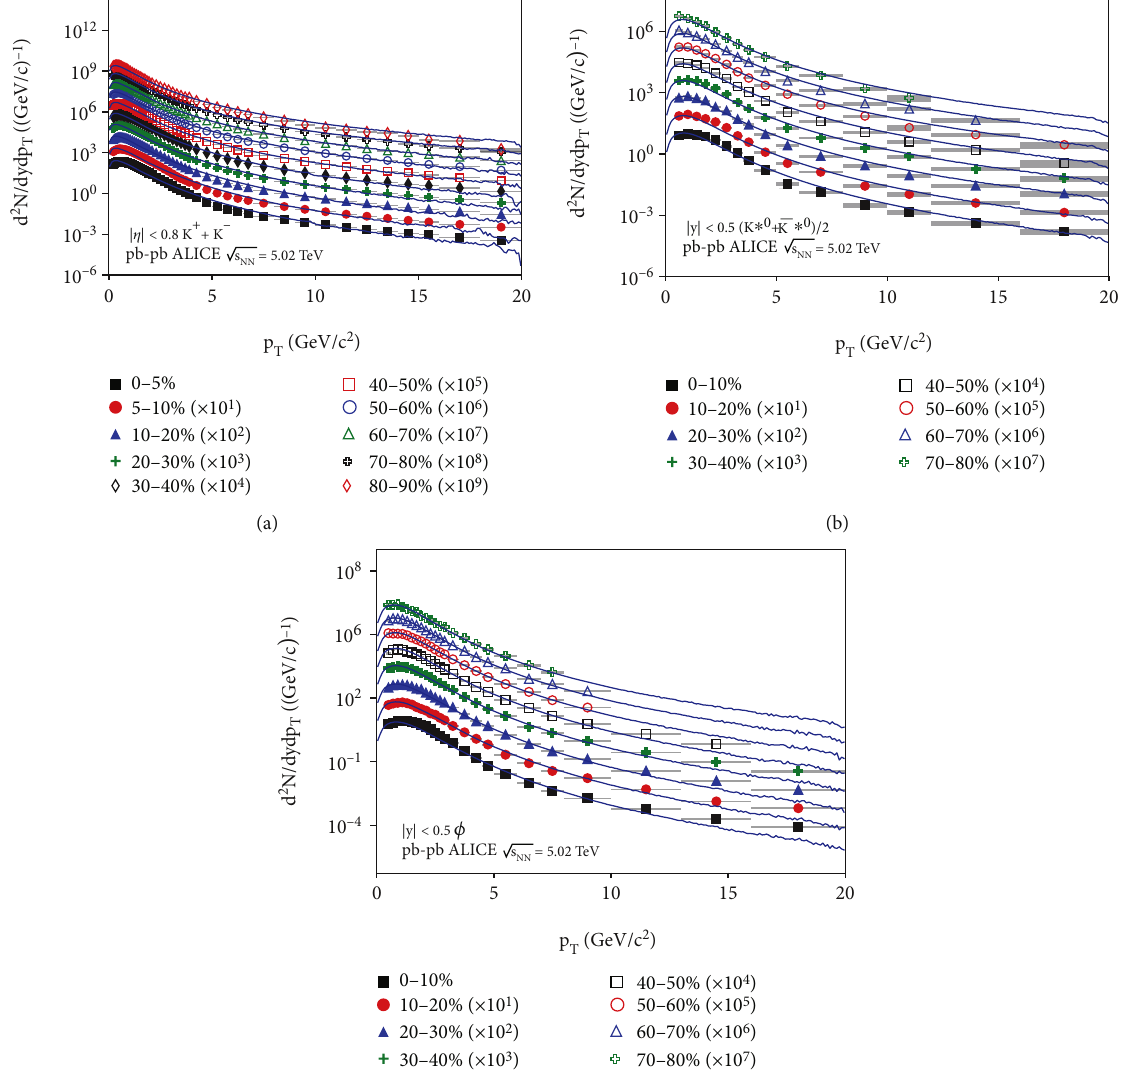
K + + K − , (b) ð K ∗ 0 + (cid:1) K ∗ 0 Þ /2 , and (c) ϕ in Pb – Pb collisions at Figure 2: The p T spectra of (a) data measured by the ALICE Collaboration [42, 43]. The solid curves represent the Monte Carlo results, based on the probability density function Equation (2) and the p T expression in Equation